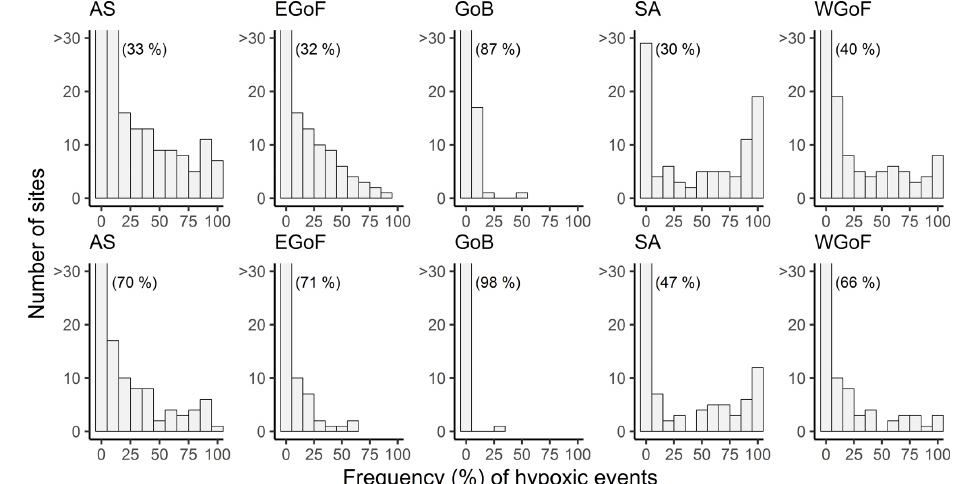
Figure 3. Frequencies of hypoxic events at coastal monitoring sites across Water Framework Directive areas: Archipelago Sea (AS), eastern Gulf of Finland (EGoF), Gulf of Bothnia (GoB), Stockholm archipelago (SA) and western Gulf of Finland (WGoF). Upper panels indicate O 2 <4.6mgL − 1 and lower panels O 2 <2mgL − 1 . Numbers in brackets indicate the percentage of sites with O 2 >4.6 (upper panel) and O 2 >2mgL − 1 (lower panel). Number of sites over 30 are not shown.